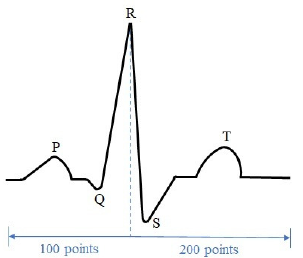
Figure 1. The structure of an ECG